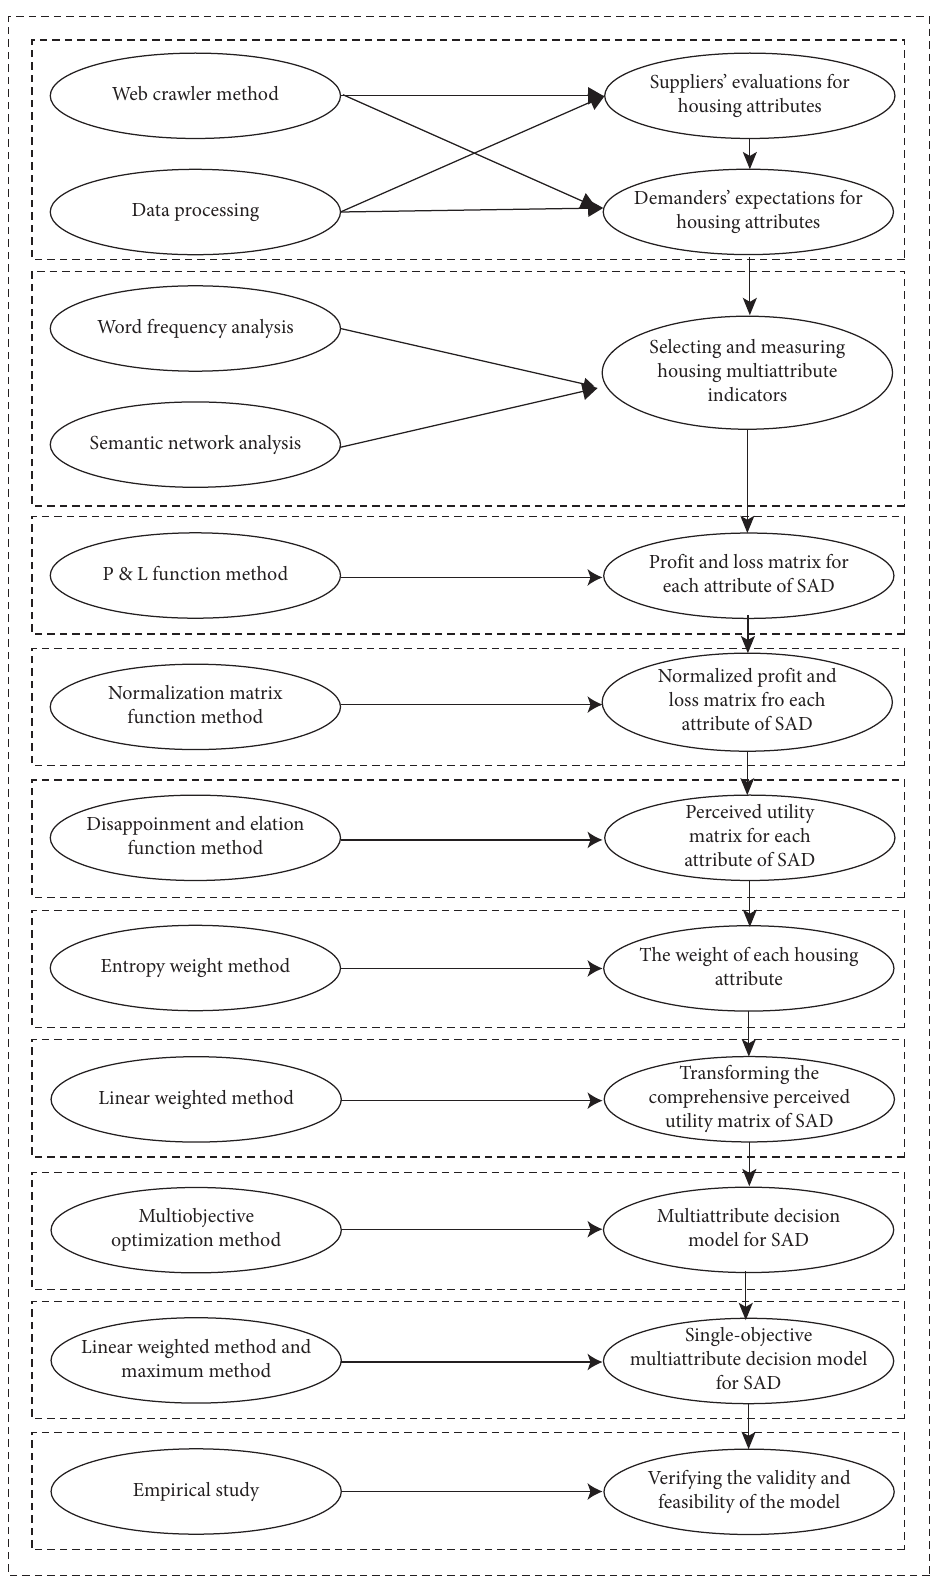
Figure 2: Schematic overview of the multiattribute SAD matching decision model for ORH based on the perceived